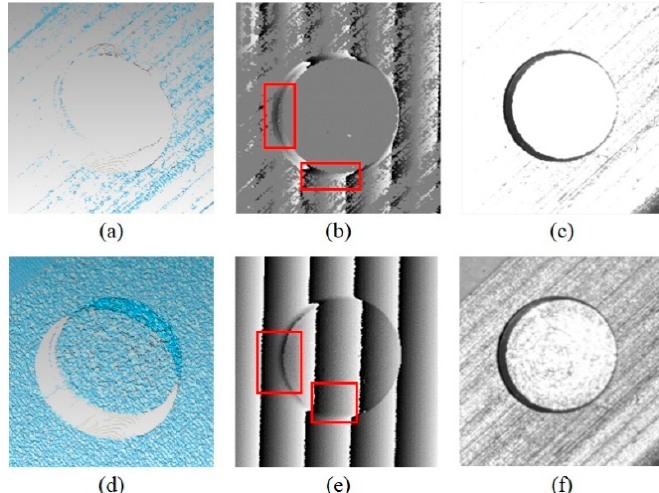
Figure 10. First row is the result of the traditional none-HDR FPP: ( a ) the 3-D reconstruction, ( b ) the